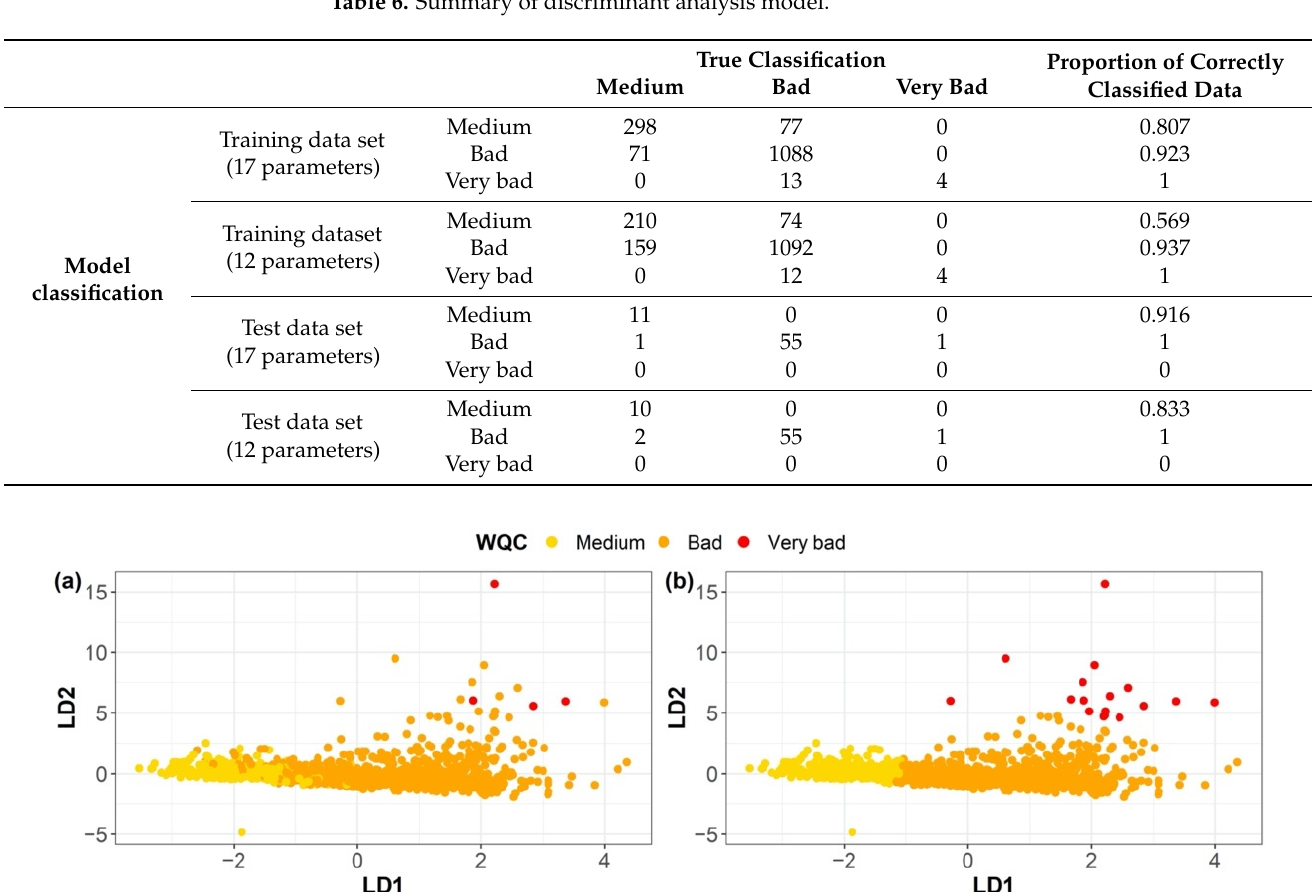
Figure 14. ( a ) Real WQC original obtained by the original WQI calculation algorithm; ( b ) predicted WQC by the linear discriminant functions using 17 parameters. Both using the training data subset. A second discriminant analysis was performed with the 12 parameters selected by Roy’s first root statistic criteria [45] and the best subset selection (Section 3.5). This new model correctly classified a proportion of 57% (210 observations) and 94% (1092 obser- vations) into the medium and bad WQCs, respectively (Table 6), with a corresponding global performance of 84% of correctly classified observations. Similarly, for the model with 17 parameters, all observations belonging to the very bad WQC were correctly assigned, however, 12 additional observations were misclassified into this category. Figure 15 shows the differences between the results of the classifications displayed by the original WQI calculation algorithm and the linear discriminant functions (using 12 parameters). The classification achieved by the model with 12 parameters was similar to that achieved by the model with 17 parameters. Finally, the LDA models (17 and 12 parameters) were applied to the testing data set and they both correctly classified a proportion of 100% (55 observations) into the bad WQC and proportions of 92% (11 observations) and 83% (10 observations) into the medium WQC,